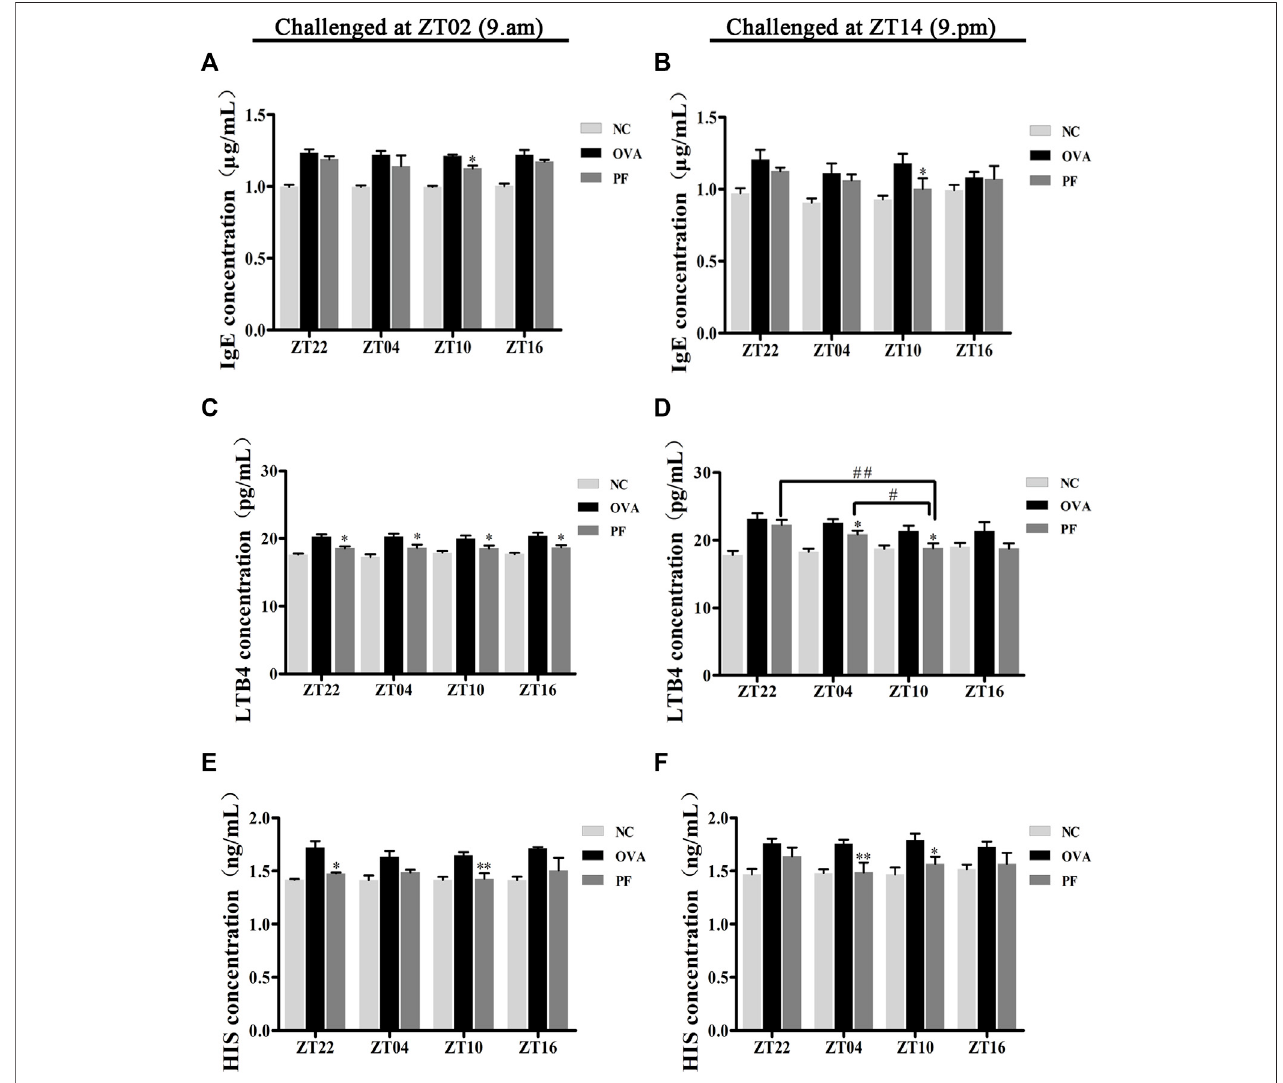
FIGURE3| EffectofPFtreatmentonthesecretionofallergiccytokinessuchas (A,B) immunoglobulinE(IgE), (C,D) leukotrieneB4(LTB4),and (E,F) histamine(HIS) from the serum samplesofOVA/aluminiumhydroxide-challengedmice. PFdownregulated theexpression ofallergic cytokines. Dataareexpressed asmean ± SEM( n (cid:1) 6). *p < 0.05, **p < 0.01 versus OVA mice at the same time points. # p < 0.05, # # p < 0.01 represents the comparison of PF ZT10 versus the other three PF groups.